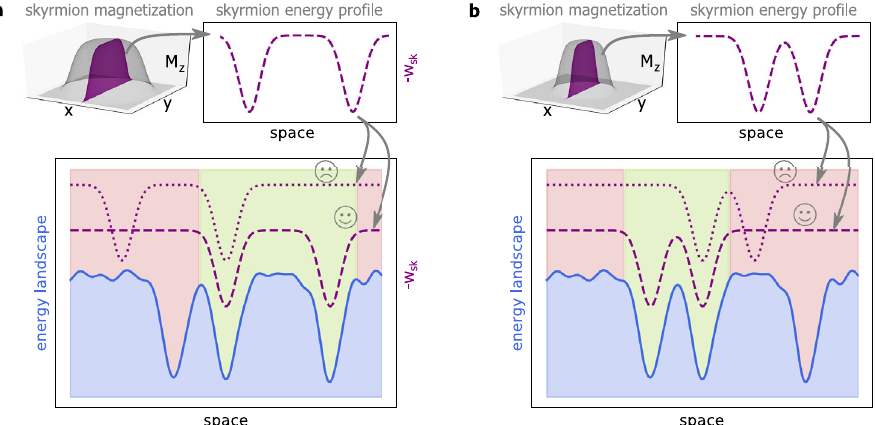
Fig. 3 Schematics of skyrmion pinning in a non fl at energy landscape. a The 3D surface schematically shows the magnetization of a skyrmion. The dashed line plot besides shows the negative energy density -w sk of this skyrmion along a pro fi le as shown by the purple plane. It indicates that the (exchange-) energy density is most important in the domain walls delineating the skyrmion. The bottom part shows an exemplary schematic of a non- fl at energy landscape in blue exhibiting three distinct minima. The peaks in energy density of the speci fi c skyrmion match two of the valleys which leads to a favorable state of low energy in the region shaded in green as indicated by the dashed purple line. Other states as in the case of the dotted purple line yield a higher energy and are therefore unfavorable to be pinned at this position as indicated by the red-shaded region. b shows a similar scenario for a smaller skyrmion. Here, a minimal energy is achieved at a different position where the skyrmion energy density best matches the energy landscape (dashed purple line in the favorable green region). Hence, the position which was favorable in ( a ) is now in the unfavorable red microscopy. The central coordinate frame in Fig. 4a shows the ferromagnetic background. The average Kerr contrast intensity of skyrmion shapes by plotting the positions of the domains walls skyrmions is depicted in the surrounding plots for every pinning that constitute the SB for skyrmions at pinning sites 1 – 4. The SB site. We see that although the corresponding skyrmion center is de fi ned as the position where the Kerr intensity intersects the coordinates deviate, their boundaries coincide in signi fi cant parts mean of the values belonging to the skyrmion core and the of the boundary length. To demonstrate the relevance of this